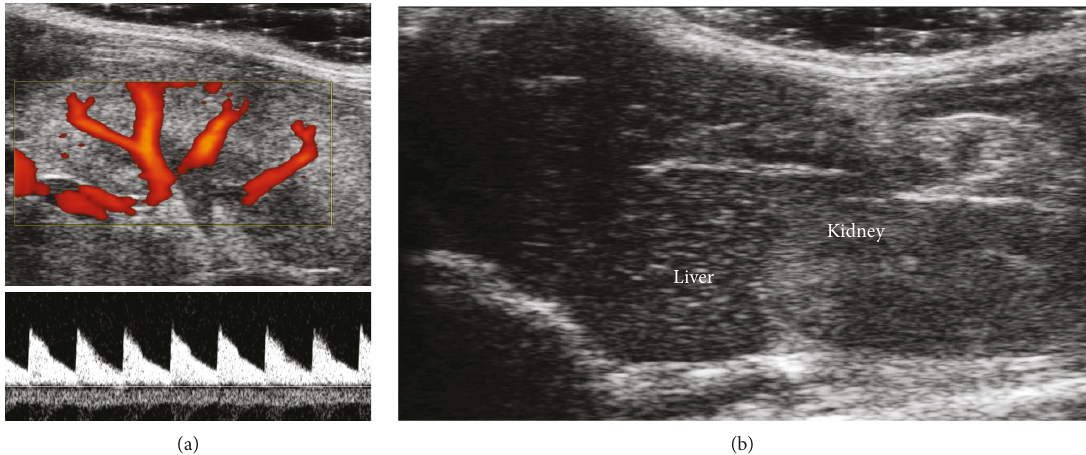
Figure 3: Kidney and liver ultrasound scan. (a) Power Doppler image was used to localize renal vessels, while PW-Doppler signal was used to measure renal blood fl ow thus deriving pulsatility and re fl ectivity indexes. (b) Mean gray levels of the liver parenchyma were compared to mean gray levels of the renal